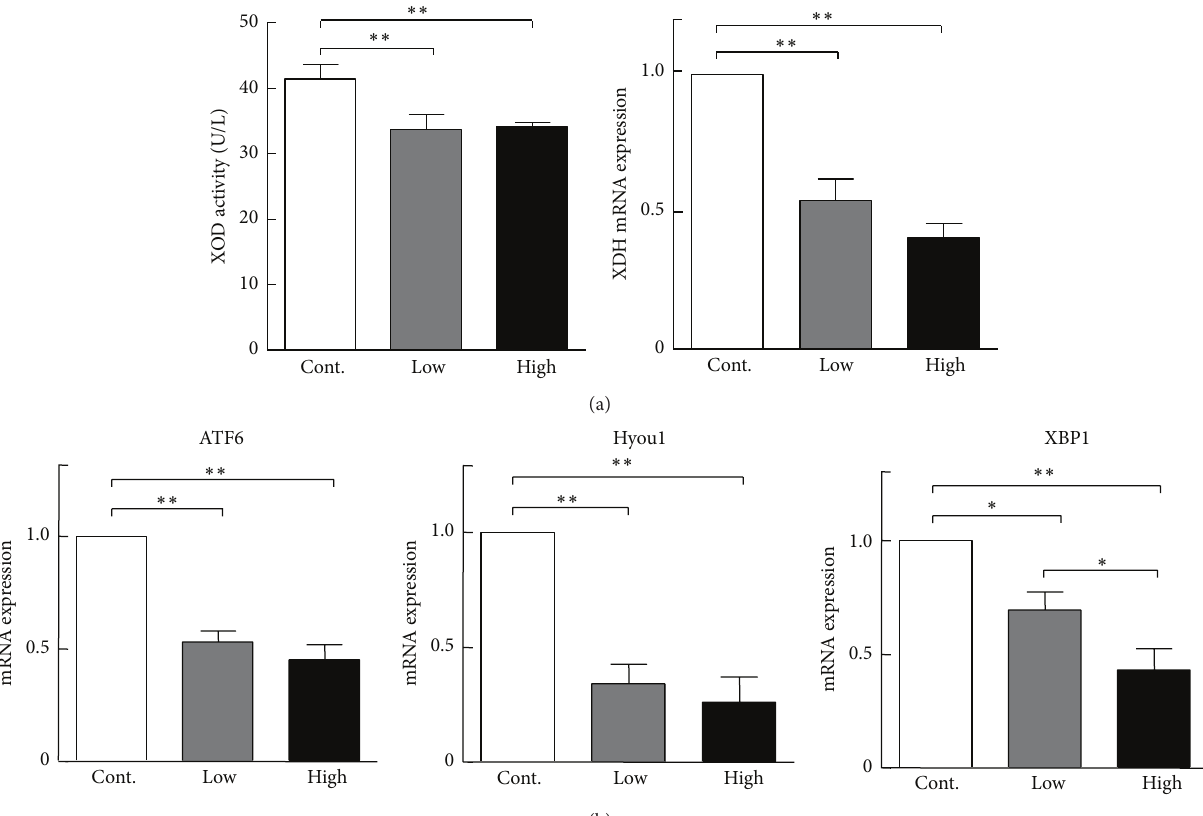
Figure 4: (a) Xanthine oxidase (XOD) protein activity of the plasma and xanthine dehydrogenase (XDH) mRNA expression in the liver. 𝑛 = 3 for each group (pooled samples). (b) RT-PCR results of mRNA expression in the liver. 𝑛 = 6 for each group. Activating transcription factor 6 (ATF6), hypoxia upregulated 1 (Hyou1), and x-box-binding protein 1 (XBP1) mRNA expression levels were analyzed by RT-PCR as described in Section 2. Data are expressed as the mean ± SEM. ∗ 𝑃 < 0.05 , ∗∗ 𝑃 < 0.01 versus